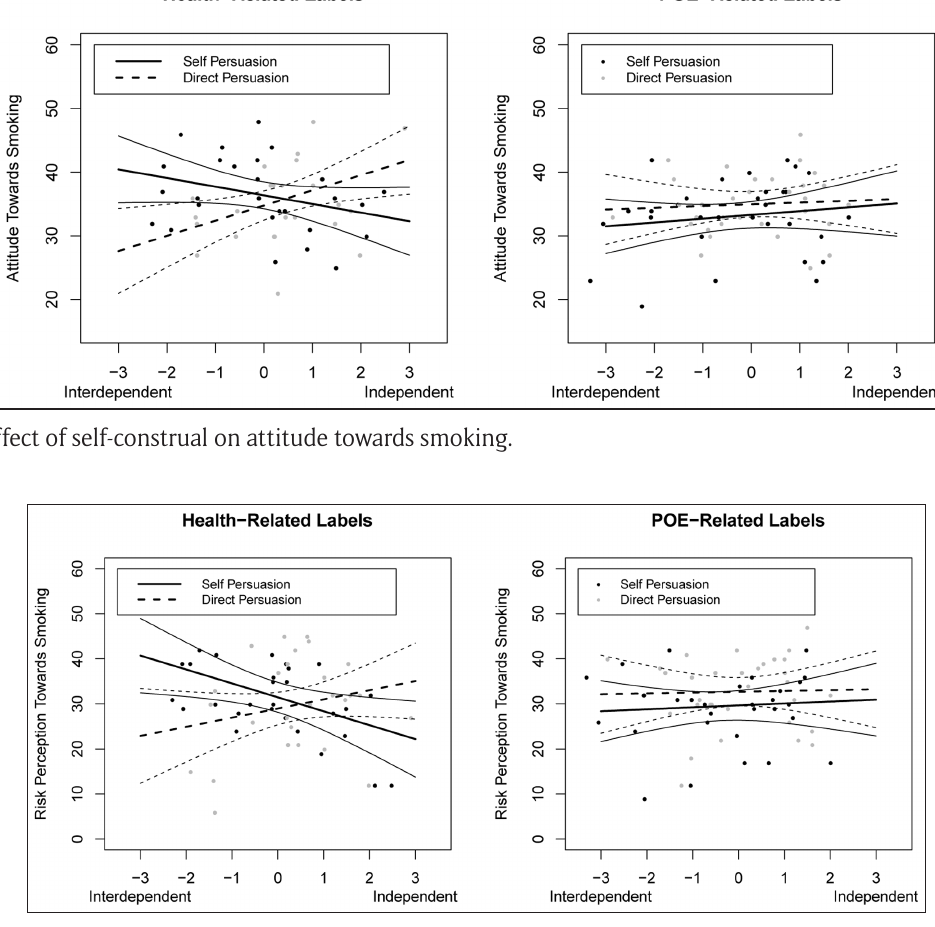
Figure 2: Effect of self-construal on risk perception towards